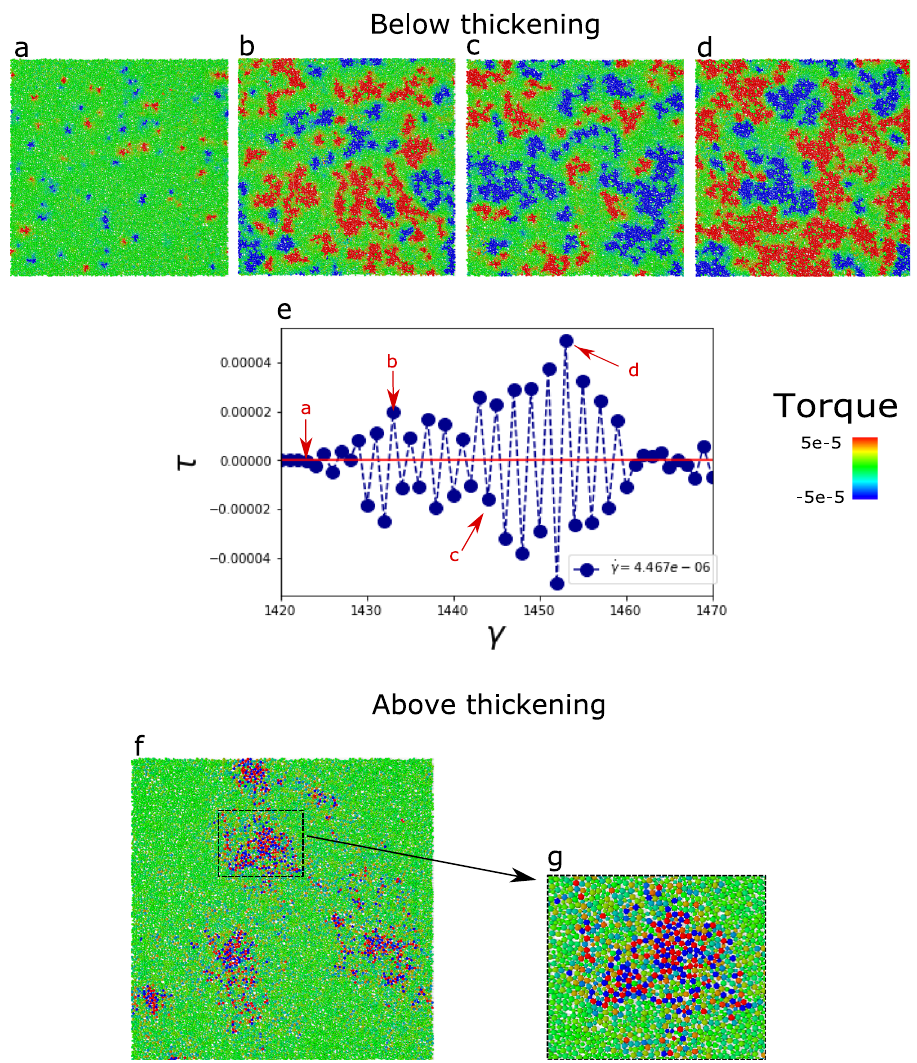
Fig. 4 Torque across discontinuous shear thickening transition. Panels ( a – d ) show subsequent snapshots of the system as it undergoes instability at global shear rate _ γ ¼ 4 : 467 ´ 10 (cid:2) 6 . The color-coding corresponds to the total torque of each particle, in which the blue particles have τ ≤ − 5 × 10 − 5 , the red particles have τ ≥ 5 × 10 − 5 , and the green particles have nearly 0 torque. As the system is sheared, domains of like-torque particles nucleate and grow, thus resulting in an enhancement in the rotational degrees of freedom, which underlies the well-known instability near the thickening transition. The mean torque as a function of strain is shown in panel ( e ), where the position of each snapshot as a function of strain is marked. Error bars are smaller than symbols. In panel ( f ), a snapshot of the system is shown above thickening for _ γ ¼ 1 : 122 ´ 10 (cid:2) 5 , where one can see localized clusters of opposite-torque particles. The binning of the color bar is similar to panels ( a – d ), and corresponds to total torque in the range τ ≤ 5 × 10 − 5 and τ ≥ 5 × − 10 − 5 . A close-up of such a cluster is given in panel ( g